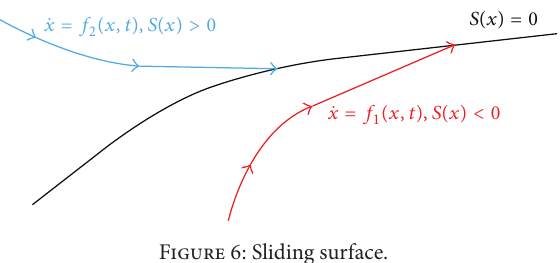
Figure 6: Sliding